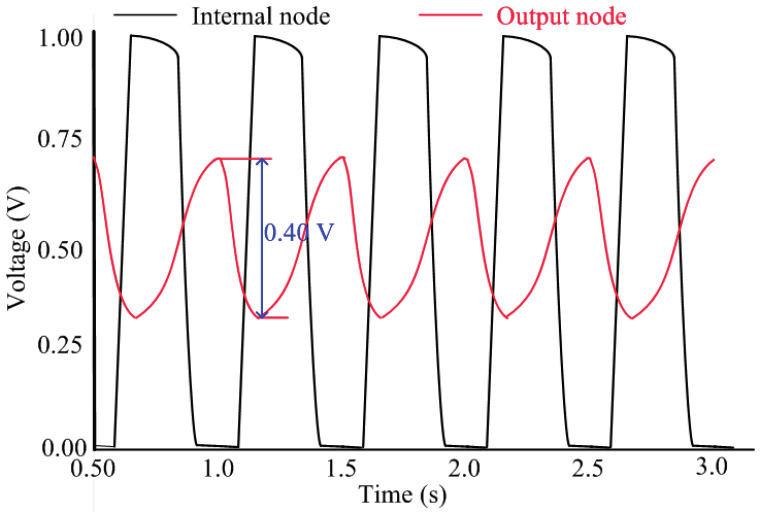
Figure 6. Output waveforms of the proposed ring oscillator at different